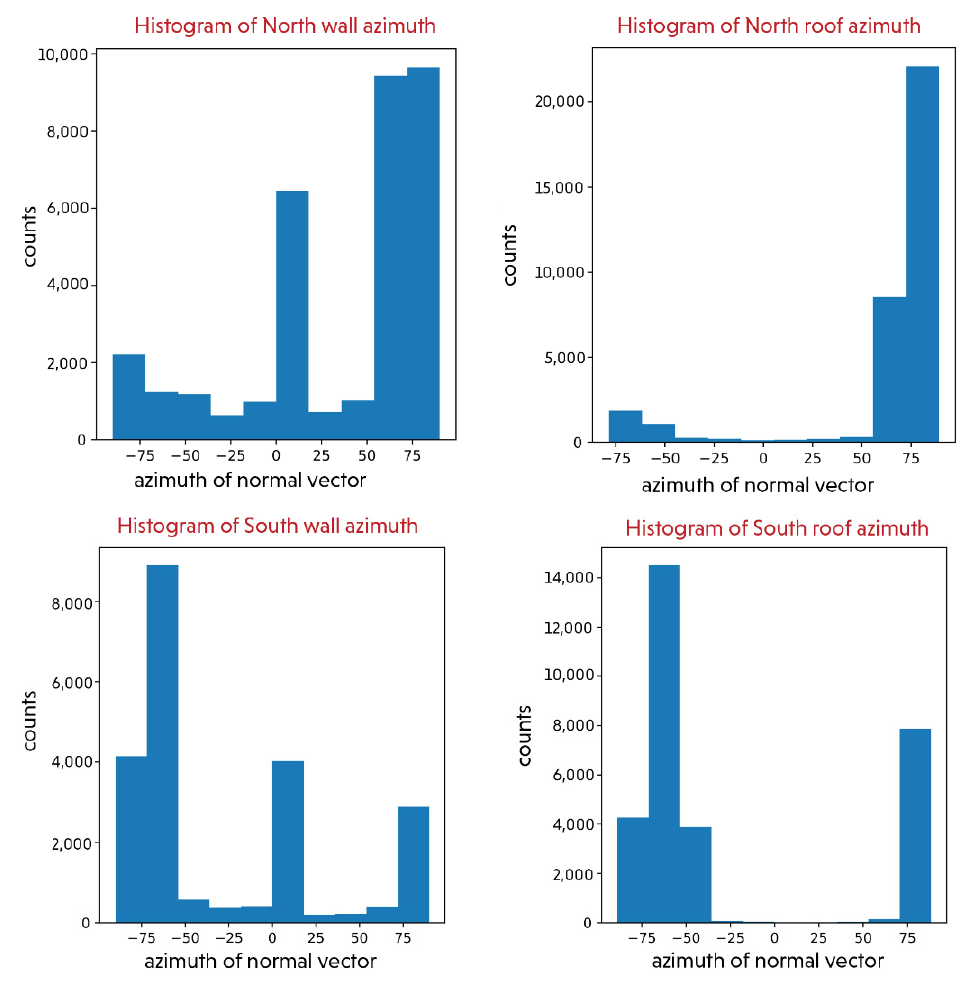
Figure 4. Distribution of azimuth of normal vectors.